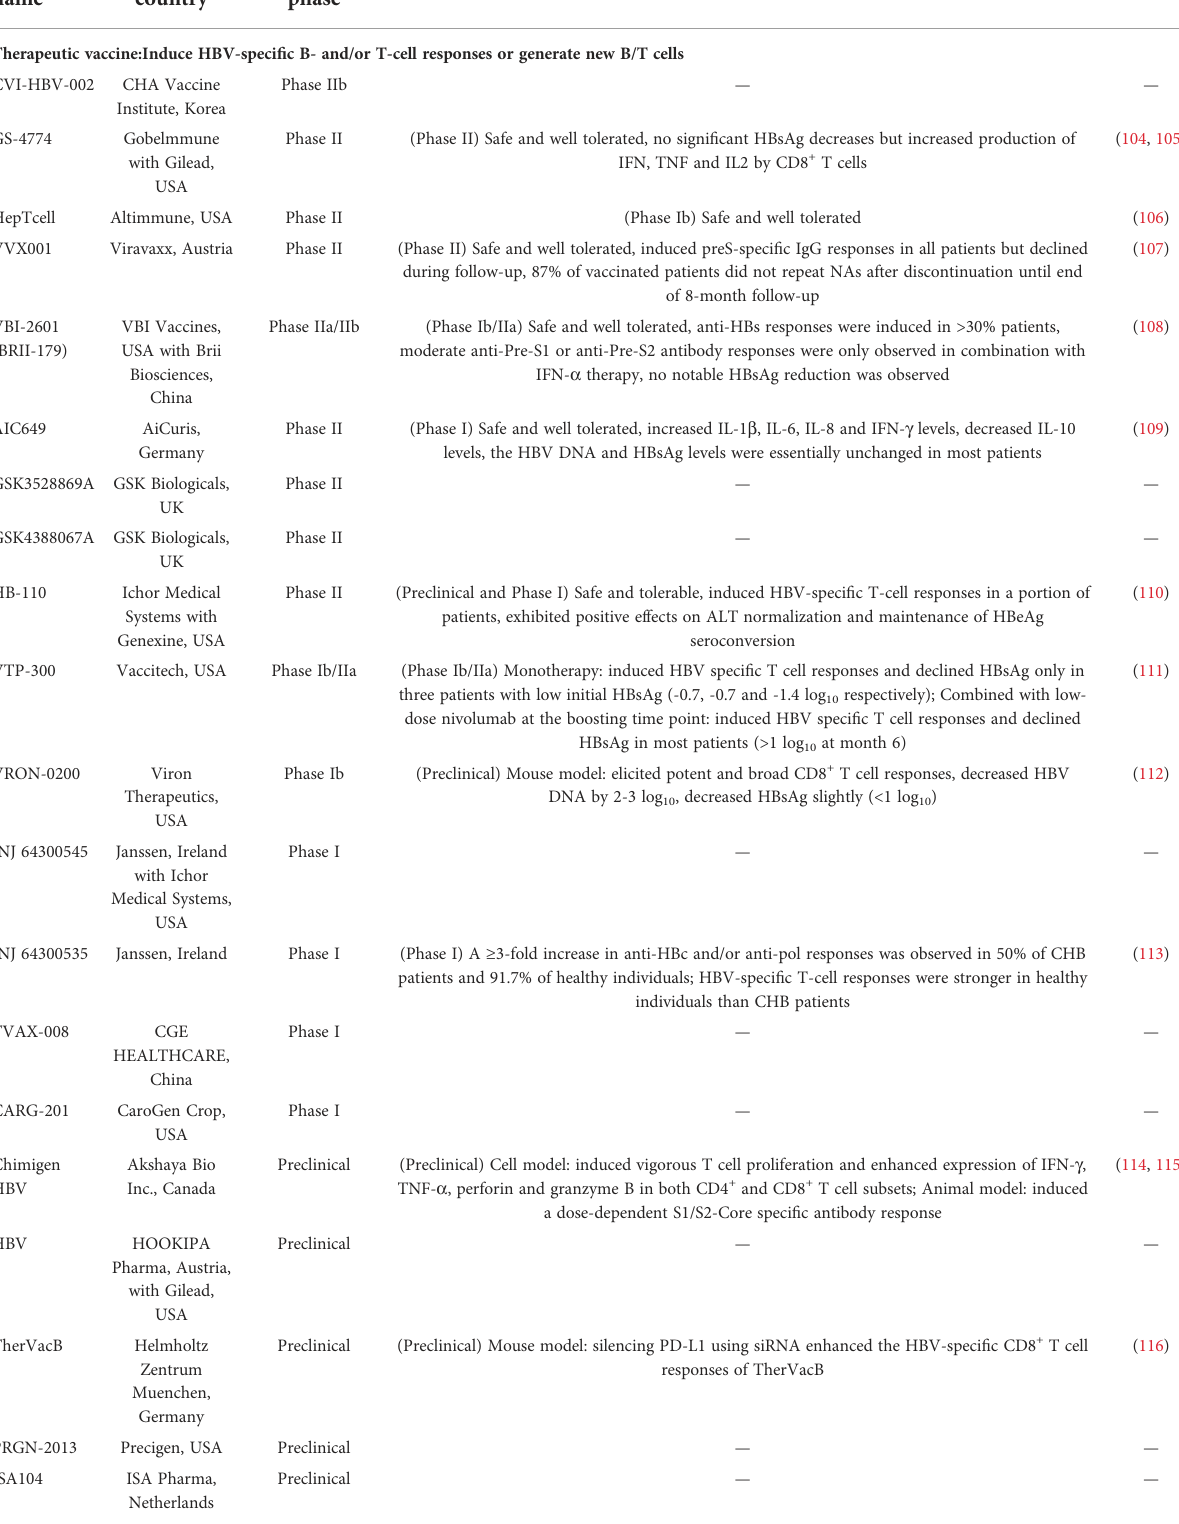
TABLE 1 Summary of immunomodulatory drugs in development for CHB infection. Drug